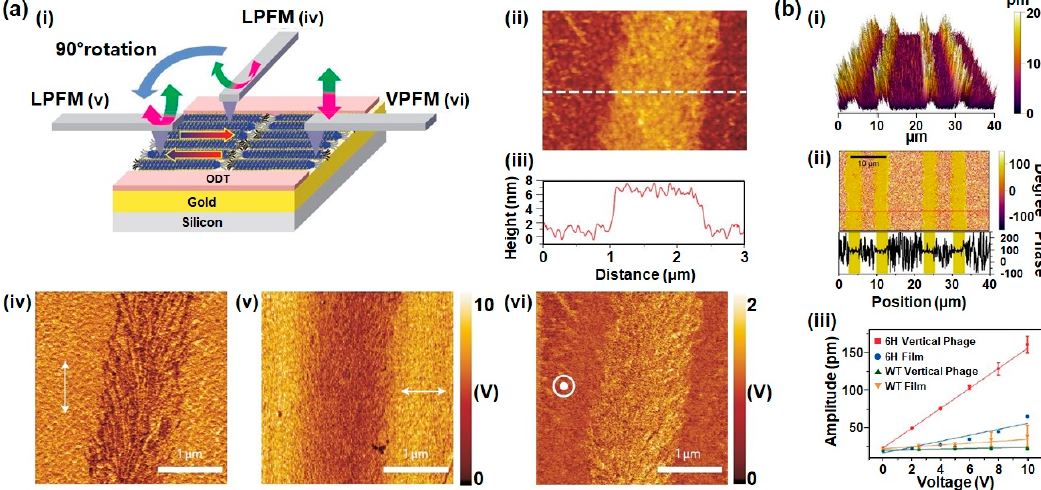
Figure 4. Piezoelectric properties of M13 bacteriophages. ( a ) Schematic of piezoresponse force microscopy (PFM) measurement (i); AFM topography (ii); height profile (iii); lateral PFM image along the phage long axis direction (iv); lateral PFM image obtained after changing the scanning direction by 90 ◦ (v); and vertical PFM image (vi) of the phage monolayer film. The resulting e ff ective piezoelectric coe ffi cients of 1E, 2E, 3E, and 4E phages were 0.14 ± 0.03 pm V − 1 , 0.35 ± 0.03 pm V − 1 , 0.55 ± 0.03 pm V − 1 , and 0.70 ± 0.05 pm V − 1 , respectively. Reproduced with permission from [28]. Copyright Nature Research, 2012. ( b ) PFM image (i), PFM phase image (ii) of vertically aligned phages which exhibits unidirectional polarization in the out-of-plane direction, and comparison of out-of-plane PFM amplitude versus applied voltage along the aligned direction (iii). The resulting e ff ective piezoelectric coe ffi cients ( d e ff ) of 6H vertical phage, 6H film, WT vertical phage, and WT film were ~13.2 pm V − 1 , ~3.96 pm V − 1 , ~0.35 pm V − 1 and 1.22 pm V − 1 , respectively. Reproduced with permission from [29]. Copyright American Chemical Society,